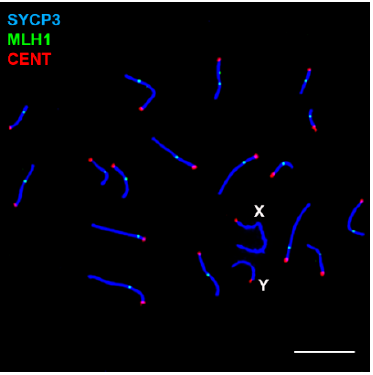
Figure 5. Distribution of MLH1 in a pachytene spermatocyte. SYCP3 (blue), MLH1 ( green ) and centromeres ( red ). All autosomes show at least one MLH1 focus. Sex chromosomes do not have any focus. Scale bar: 10 µ